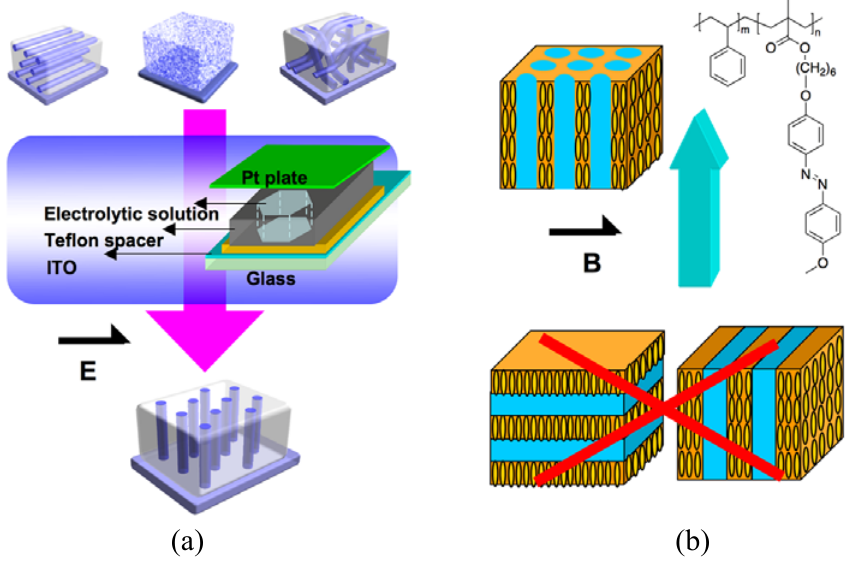
Figure 16. Control of nanocylinders in PRBCs by electric (a) and magnetic fields